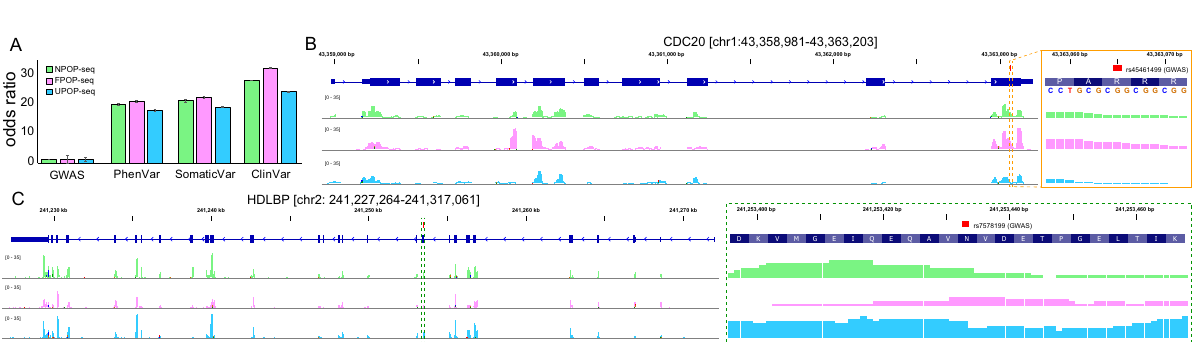
Figure 6. Somatic variation captured in POP-seq peaks. ( A ) Bar plot showing the enrichment (odds ratio) of genomic variations (GWAS, PhenVar, ClinVar and somatic variations) in POP-seq peaks, statistically tested using Fisher’s exact test. Genomic tracks showing the POP-seq peaks spanning the genetic risk loci (GWAS SNP) associated to ( B ) acute myeloid leukemia in CDC20 and ( C ) chronic myeloid leukemia in